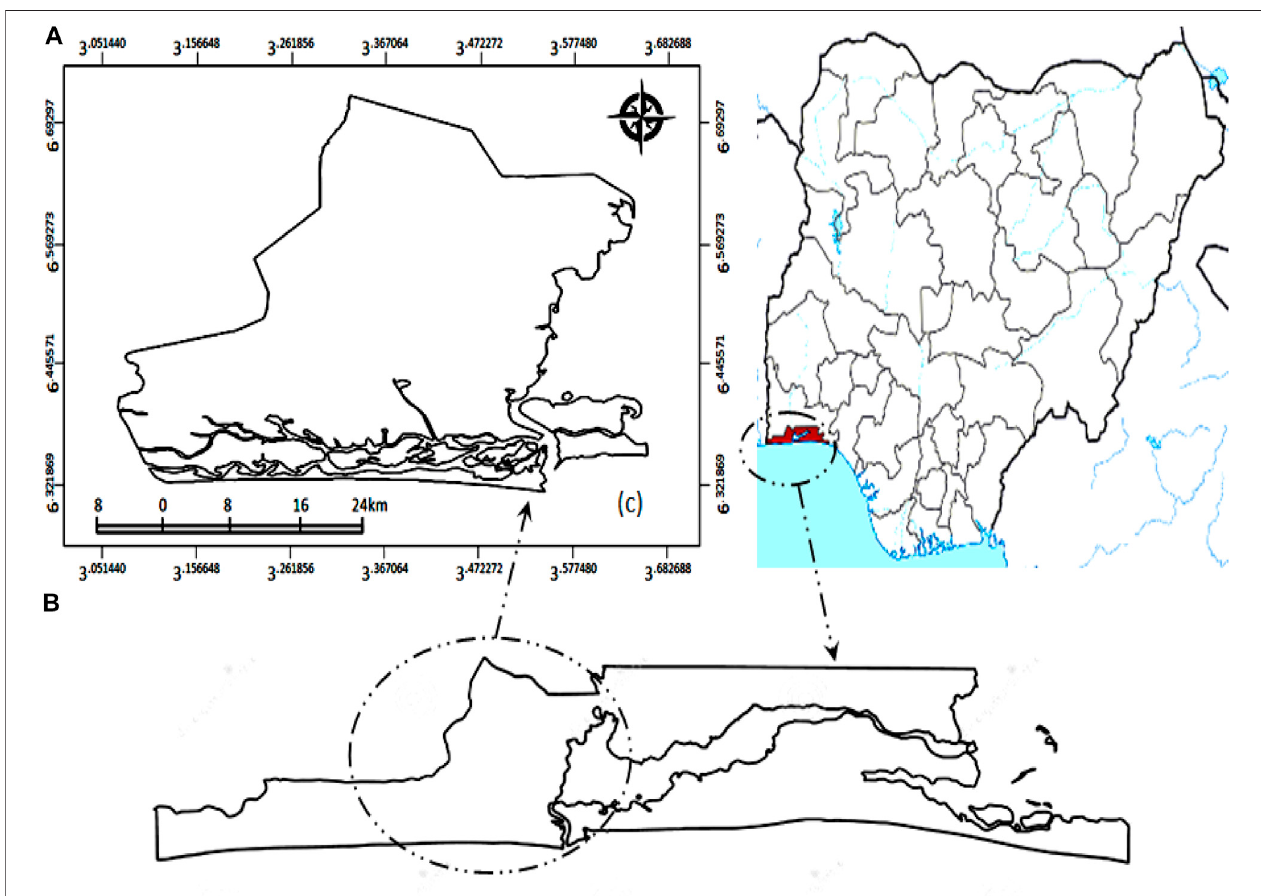
FIGURE 2 | Location map showing: (A) Nigeria (B) Lagos State (C) Metropolitan study